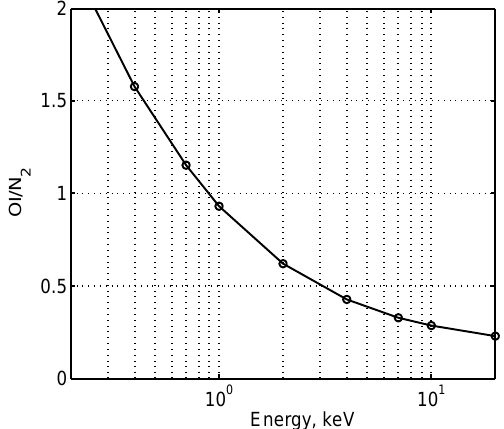
Fig. 9. Modelled OI/N 2 ratio vs peak monoenergetic energy with input flux of 2mW/m 2 .